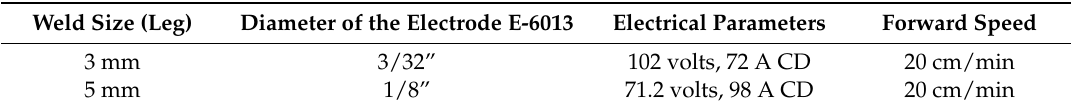
Table 1. Main characteristics of the welding procedures used.